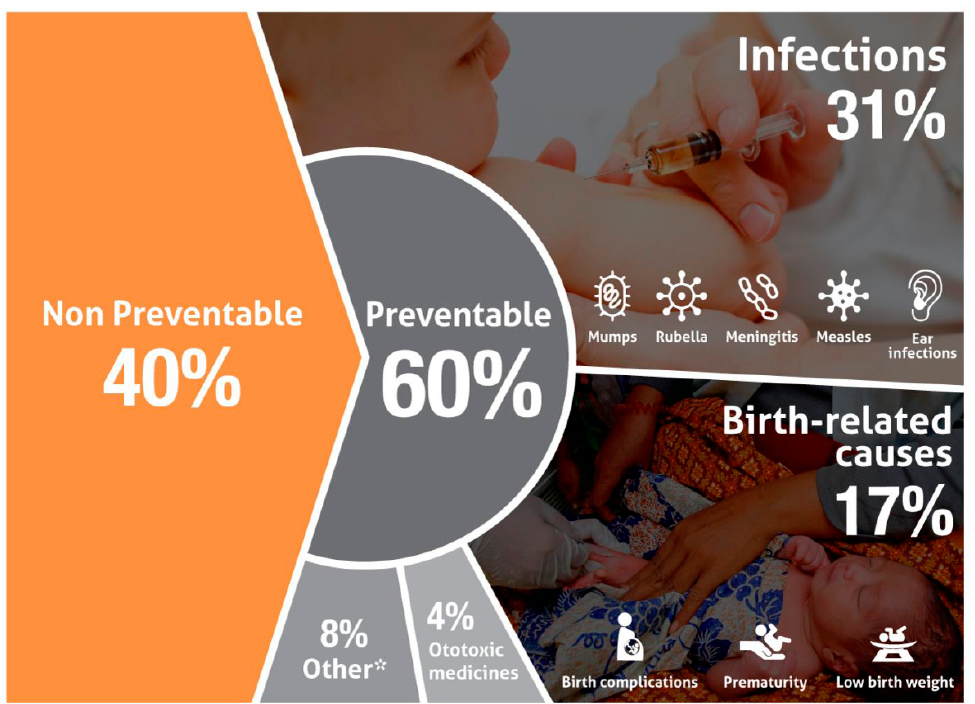
Figure Figure 2. Causes of preventable hearing loss. Other causes include congenital non-genetic malformations and other maternal prenatal causes (from: [18]).